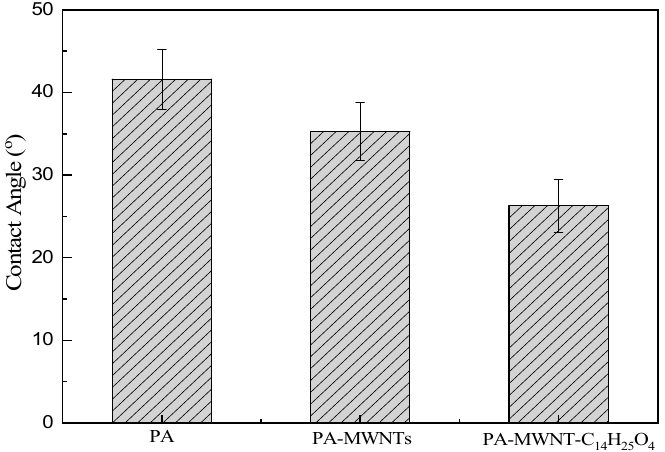
Figure 7. Contact angle of the PA membrane and PA-CNT composite membranes.